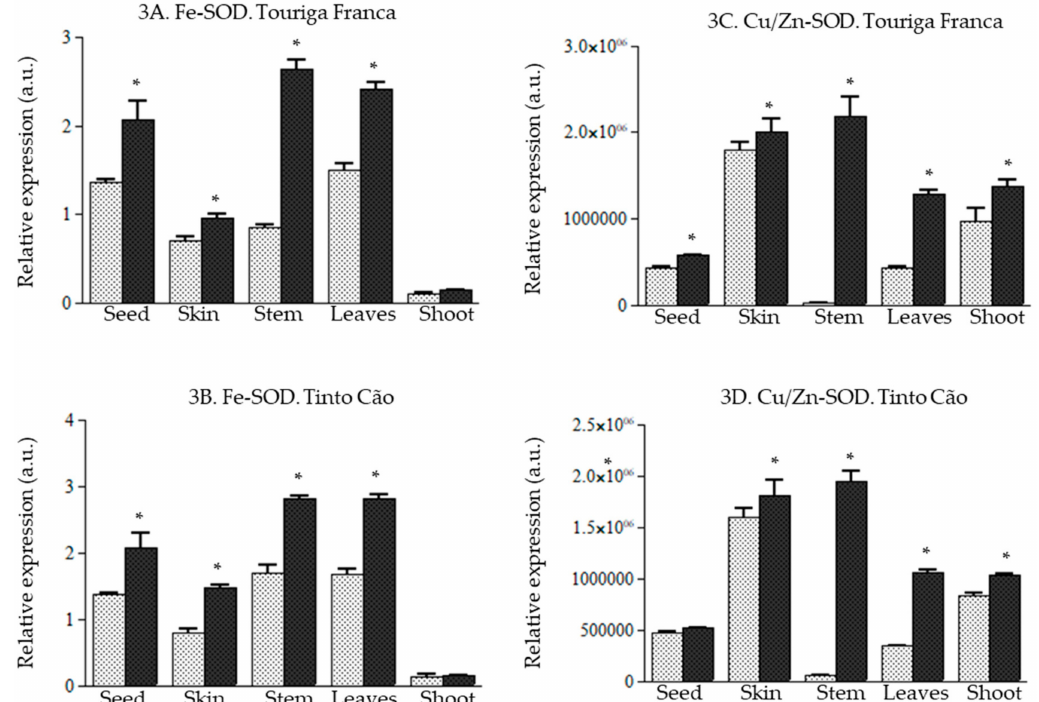
Figure 3. E ff ect of chitosan on Fe-SOD (Fe superoxide dismutase) and Cu / Zn-SOD (Cu / Zn superoxide dismutase) genes in the tissues of grapevine ( A ). relative expression of Fe-SOD gene in Touriga Franca, ( B ). relative expression of Fe-SOD gene in Tinto C ã o, ( C ). relative expression of Cu / Zn-SOD gene in Touriga Franca, ( D ). relative expression of Cu / Zn-SOD gene in Tinto C ã o. Tissues were collected at complete maturation of the berries. Gray column = control samples; black column = chitosan-treated samples. All data were obtained from three biological replicates; standard deviations and the levels of significance ( p < 0.05; t -test) are represented by error bars and asterisks above the columns, respectively.